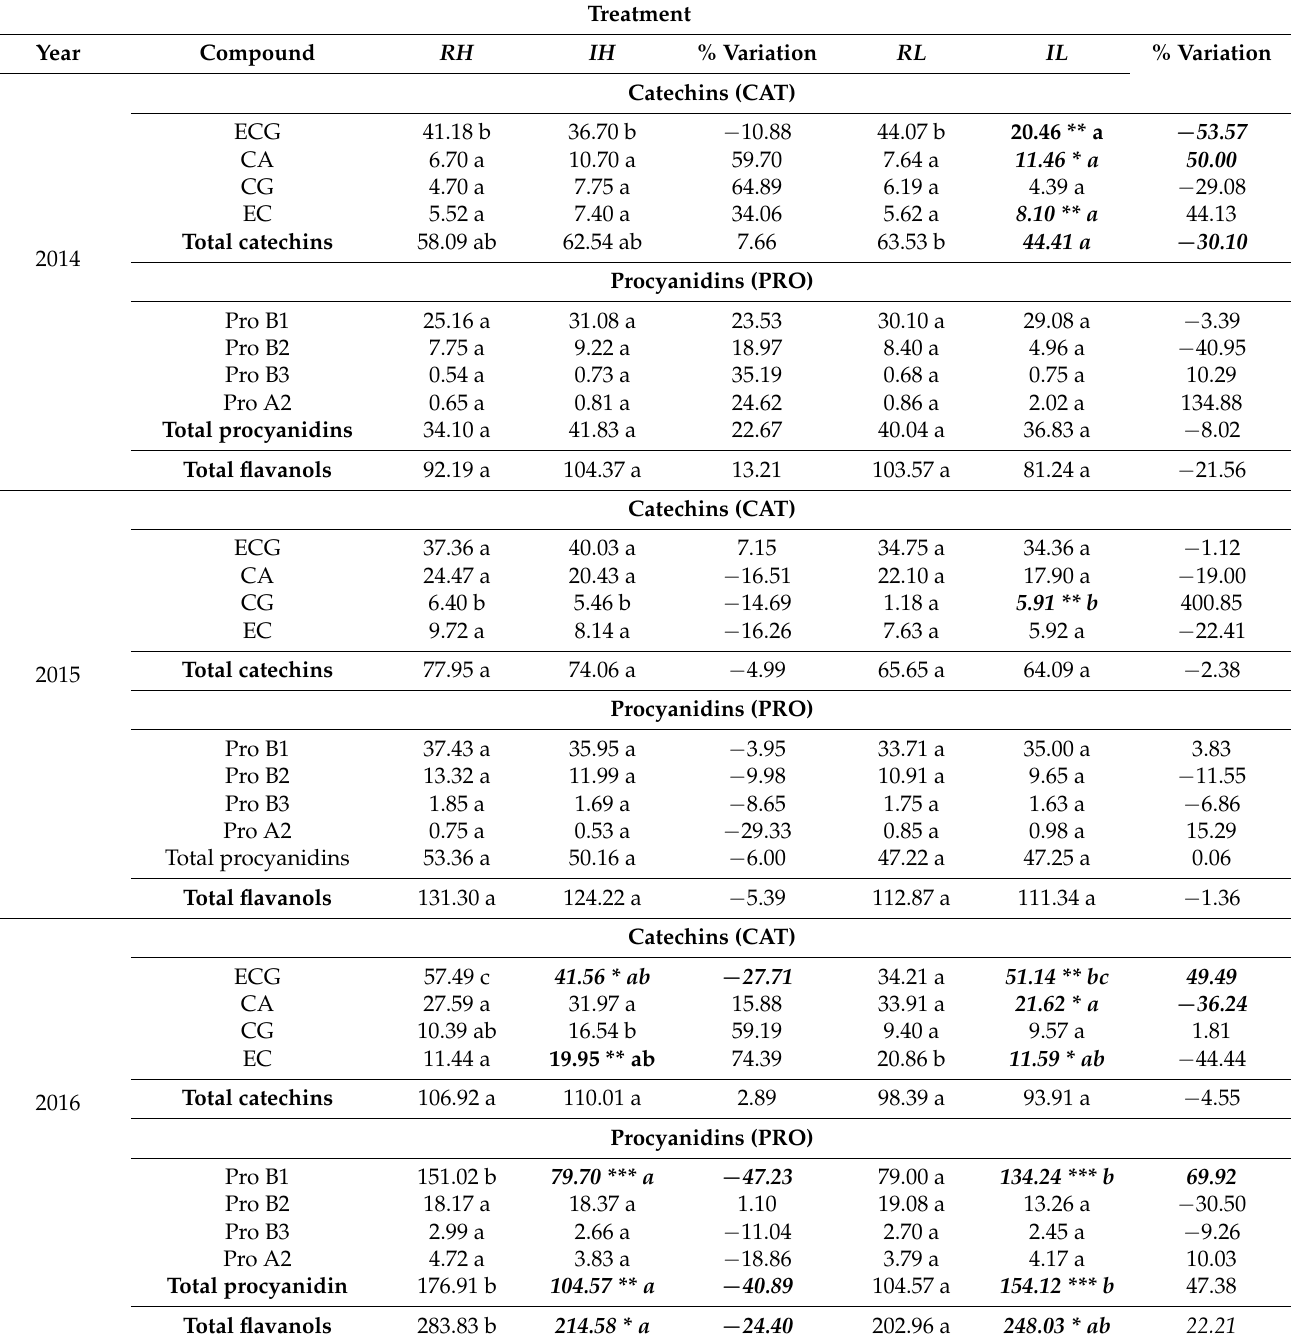
Table 6. Influence of irrigation on concentration of flavanols compounds (mg. kg − 1 berry fresh weight) under two crop load levels. R : rainfed; I : non-limiting irrigation; H : high crop load; L : low crop load. EGC: ( − )-epigallocatechin; CA: (+)-catechin; CG: ( − )-catechin gallate; EC: ( − )-epicatechin; Pro B1, B2, B3 and A2: procyanidin B1, B2, B3 and